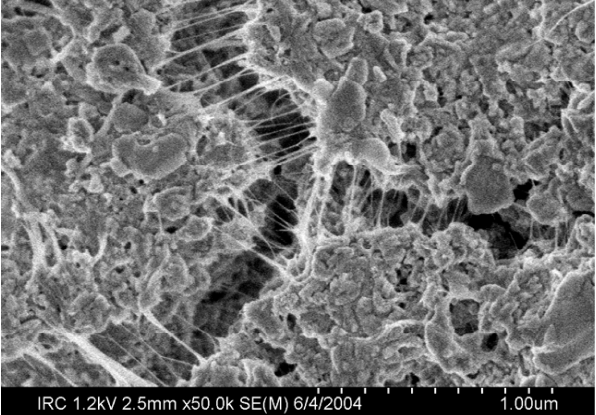
Figure 5. SEM micrograph. Crack bridging carried out by CNTs in OPC (reproduced from [135]).